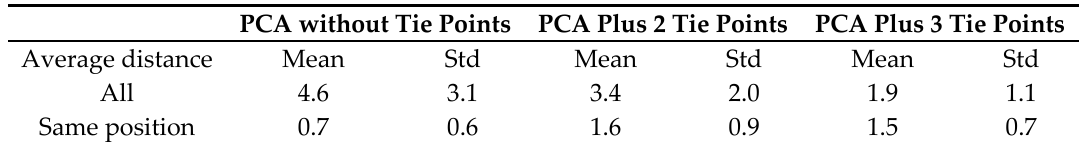
Table 1. Distances between registered models